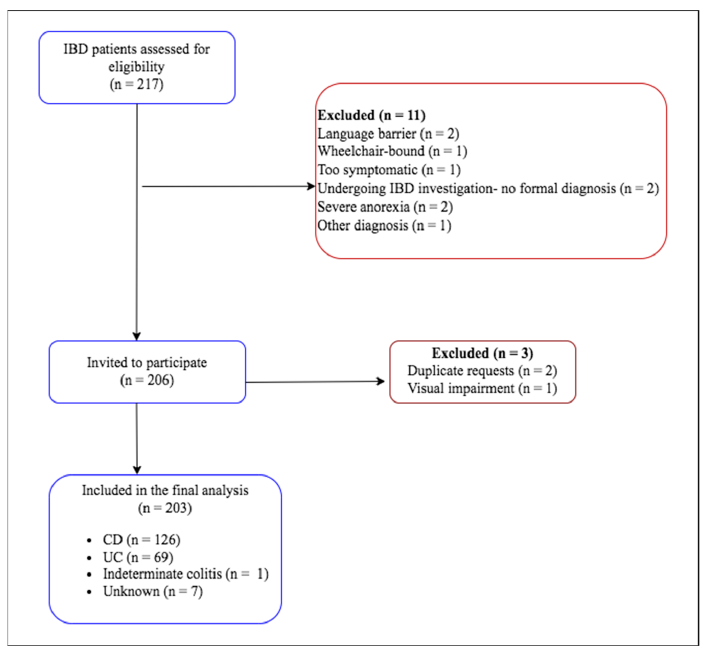
Figure 4. STROBE Flow diagram. IBD—inflammatory bowel disease; CD—Crohn’s disease; UC— ulcerative colitis.